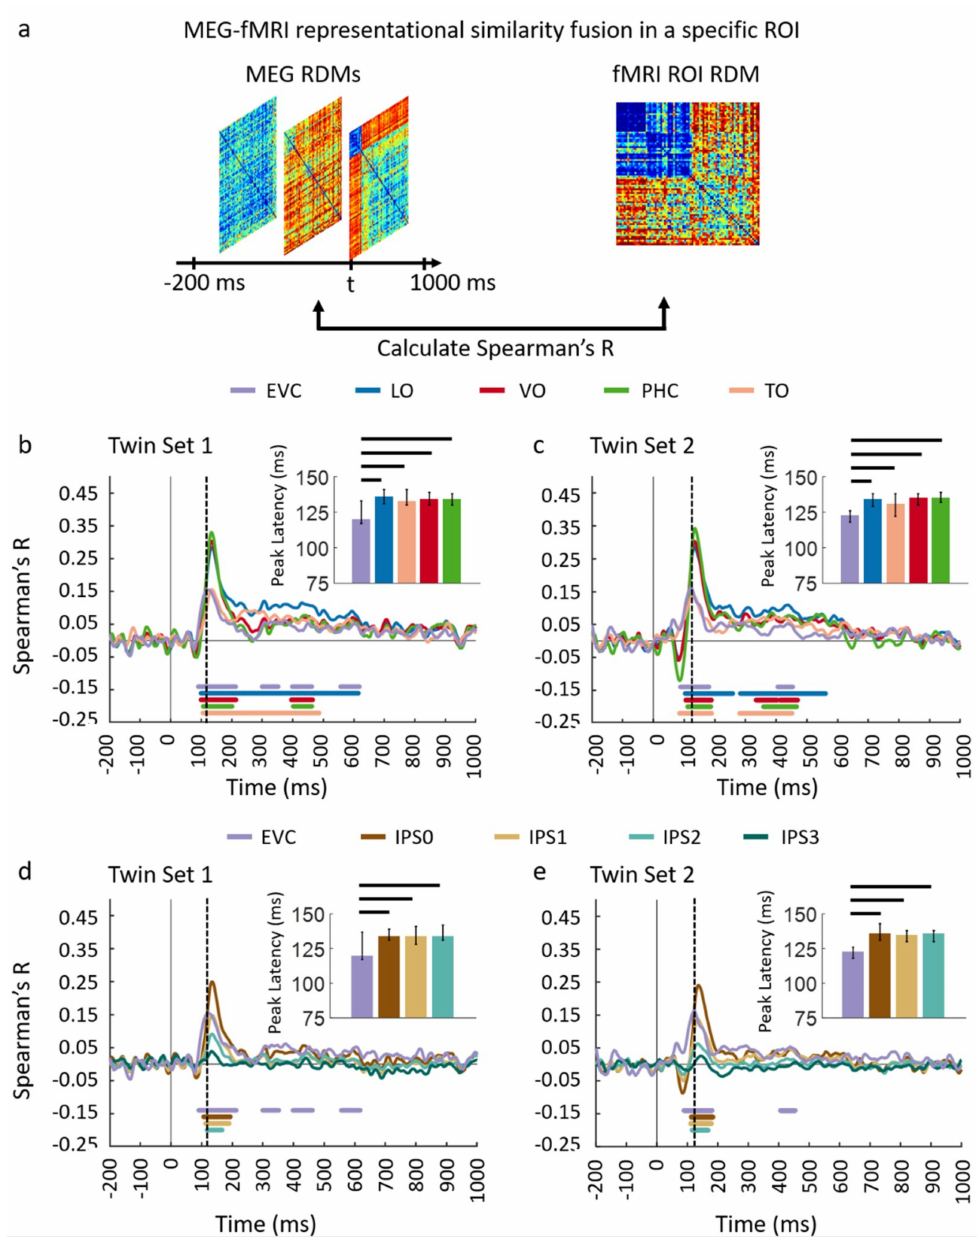
Figure 4. Comparing dorsal and ventral stream neural representations through similarity-based ROI fMRI-MEG fusion. ( a ) The voxel patterns are extracted from each ROI to construct the fMRI ROI RDM. Then the ROI-specific fMRI RDM was compared with time-resolved MEG RDMs resulting in correlation time series for each region of interest; ( b,c ) The fMRI-MEG fusion time series are depicted in EVC and ventral ROIs, LO, VO, PHC, and TO for Set 1 and 2, respectively; ( d,e ) The fMRI-MEG fusion time series are depicted in EVC and dorsal ROIs, IPS0-3 for Twin-set 1 and Twin-set 2, respectively. The color-coded lines below the curves indicate significant time points (n = 15, cluster-definition threshold P < 0.01, cluster threshold P < 0.01) and the dashed vertical line in each plot indicates the peak latency in EVC time series. Peak latency times and their corresponding 95% confidence intervals for correlation time series in bcde are illustrated with barplots and error bars, respectively. Black lines above the bar indicate significant differences between conditions. 95% confidence intervals were found with bootstrap tests and barplots were evaluated with two-sided hypothesis tests; false discovery rate corrected at P <